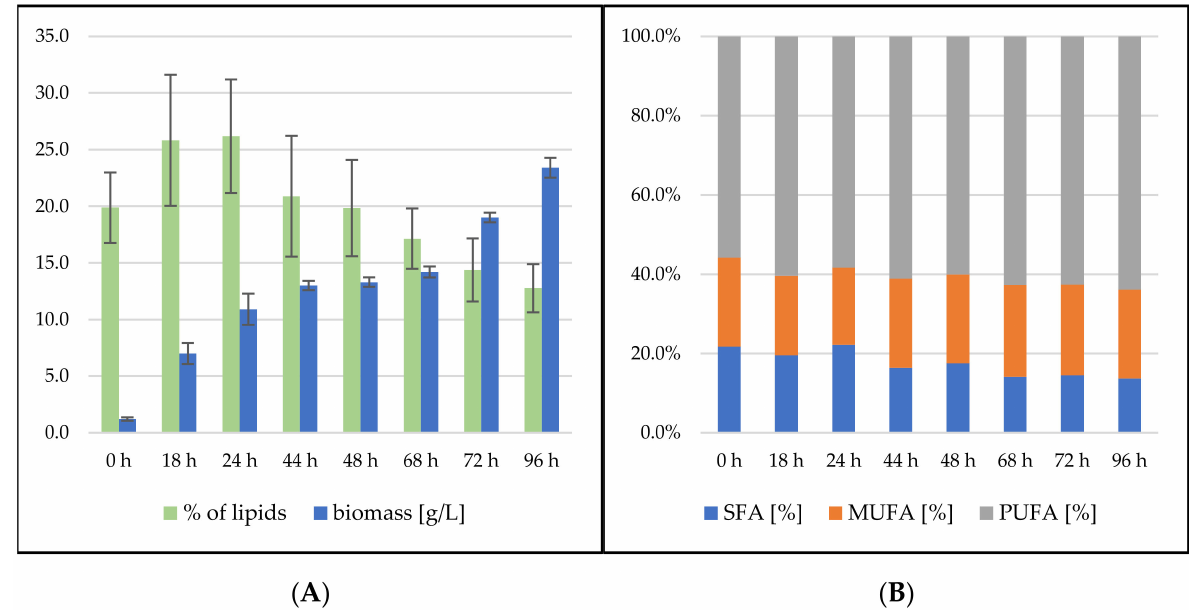
Figure 5. Sporidiobolus pararoseus bioreactor cultivation on SCG hydrolysate + coffee oil. ( A ) Biomass production (g/L) and total lipid production (%); ( B ) Fatty acid profile